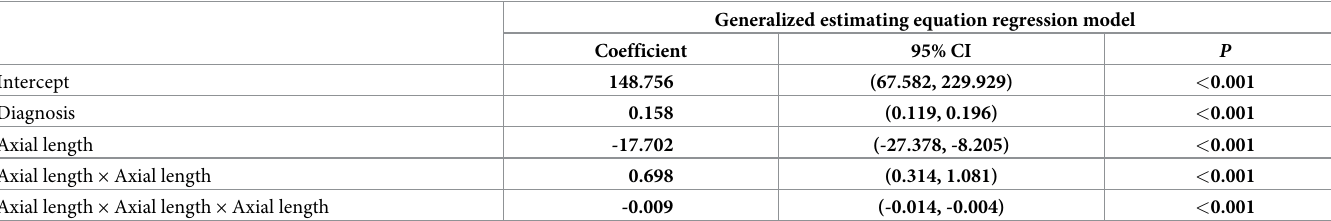
Table 3. Offset Index according to diagnosis and axial